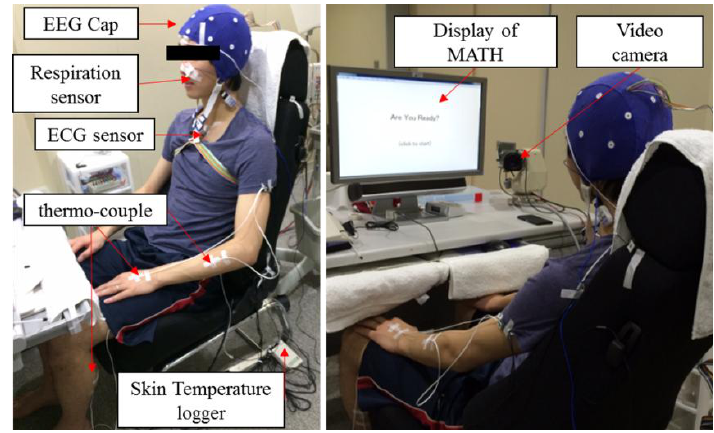
Figure 3. Field photos of the experimental scene.